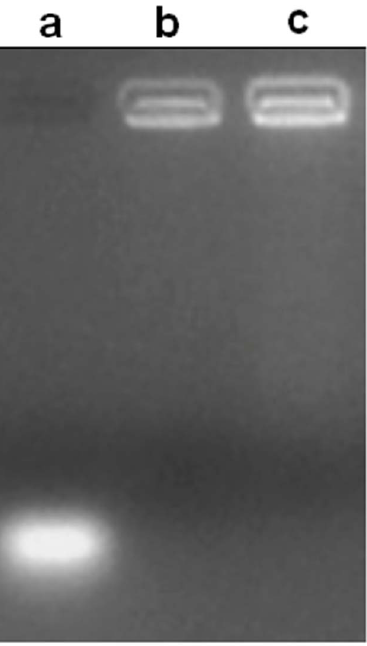
Figure 2. Gel retardation assay of NP probe complex. (a) QD- RNA-Au NP probe, (b) QD-RNA-Au NP probe loaded CS, and (c) QD- RNA-Au NP probe loaded CS/ c -PGA complex.